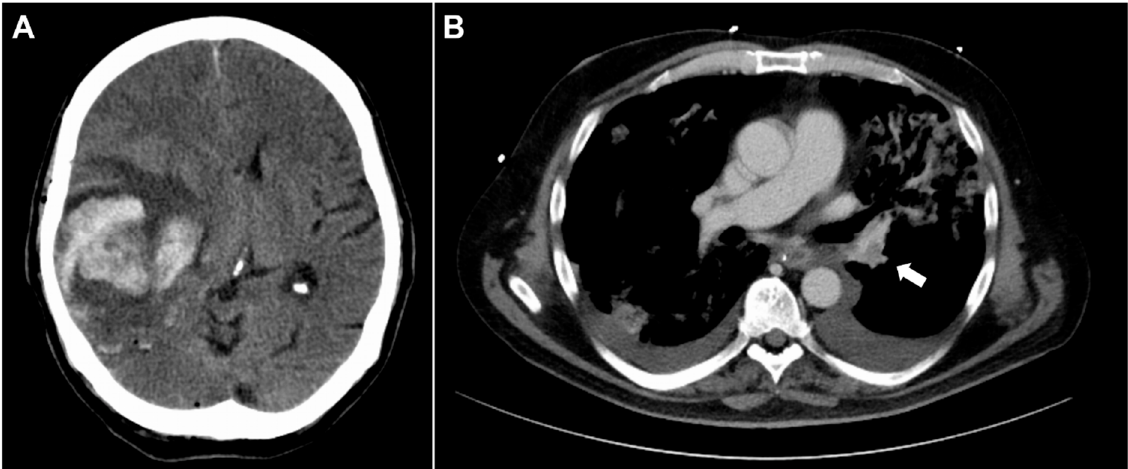
Figure 1. ( A ) Computed tomography (CT) scan of a postoperative rebleeding after glioma resection. ( B ) Pulmonary embolism is a complication commonly seen in neurosurgical patients.